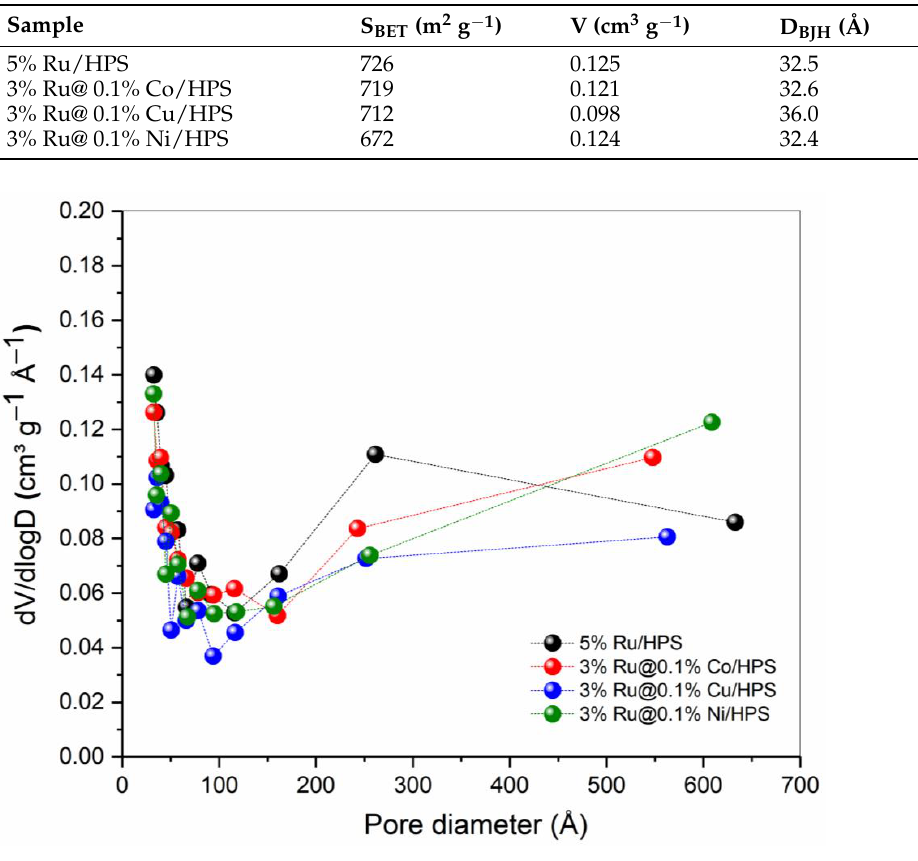
Figure 5. Ruthenium and doped ruthenium/HPS catalysts pore volume distribution compilation. Table 2. BET specific surface area (SBET), pore volume (V) and average pore diameter (DBJH) for doped and non-doped ruthenium/HPS catalysts.